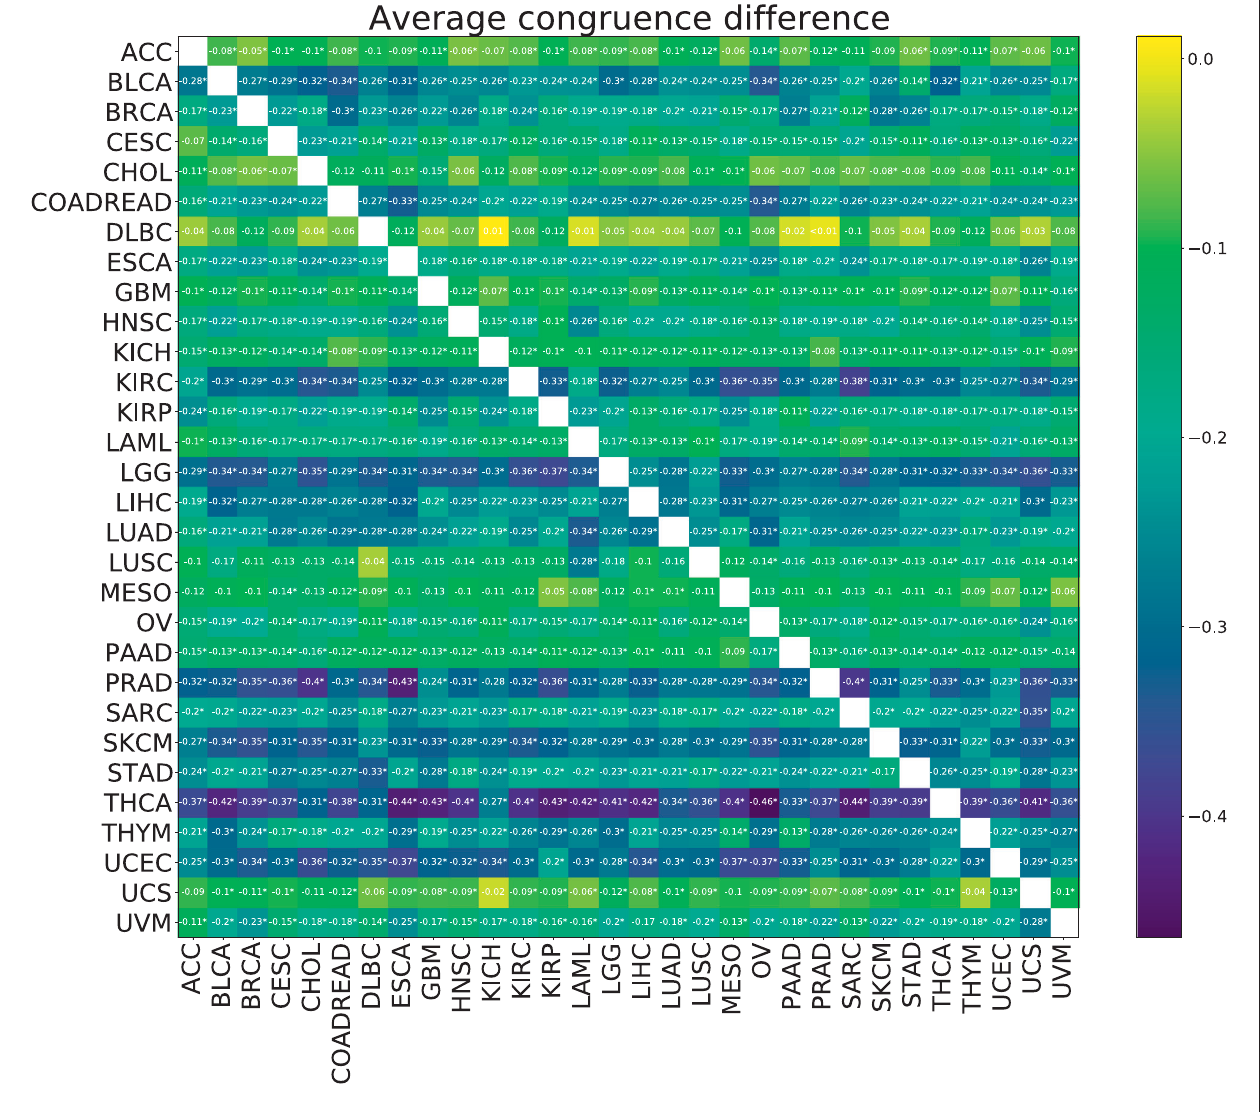
FIGURE6| Heatmap showingthemeanpaired difference incongruencebetweensingleand multi-tasktraining. Positivevaluescorrespondtotheimprovementof model stability with multi-tasking. The row gives the cancer for which the congruence was calculated and the columns give the cancer with which the target cancer was paired for the multi-task training. Asterisks (*) indicate signi fi cance with the FDR corrected p -value p < 0.05.